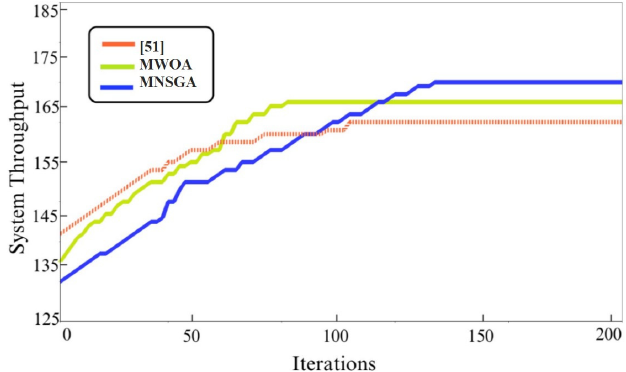
Figure 5. Convergence analysis comparison [51].